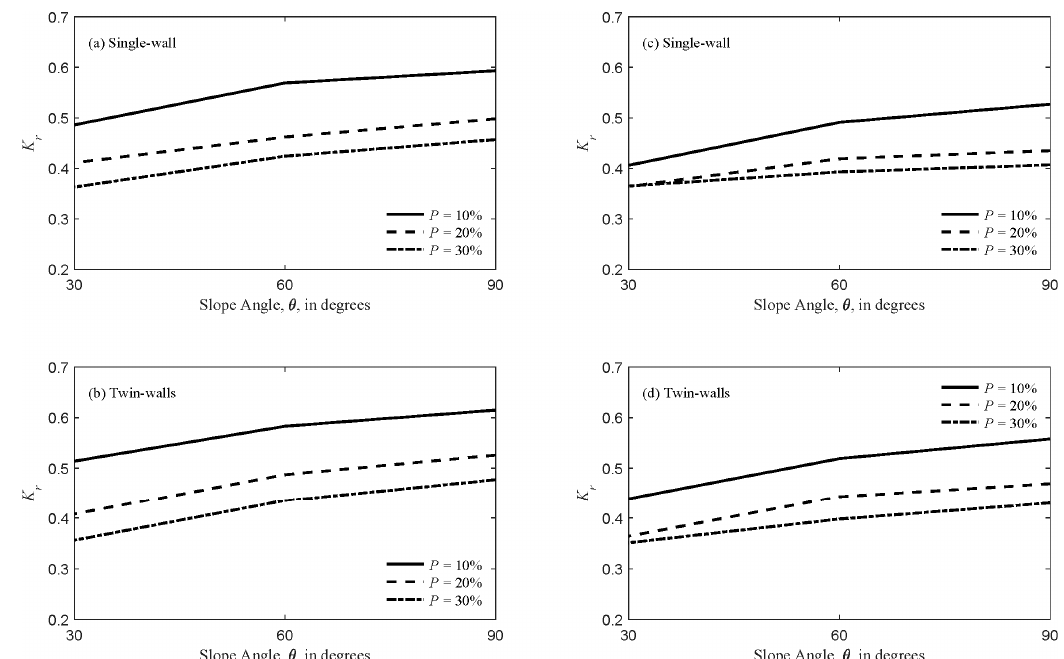
Figure 17. Variation of K r with θ for d / L p = 0.1083, and different porosities and wall configurations. On the left, H is / d = 0.2493 ( a and b ) and on the right H is / d = 0.1284 ( c and d ).